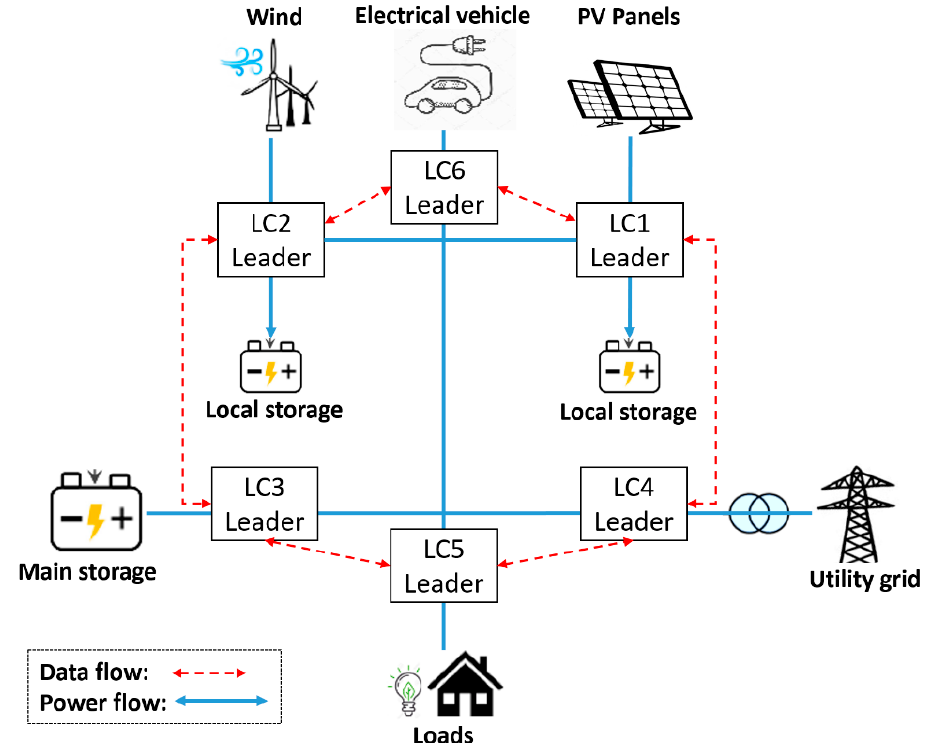
Figure 3. Decentralized control structure.